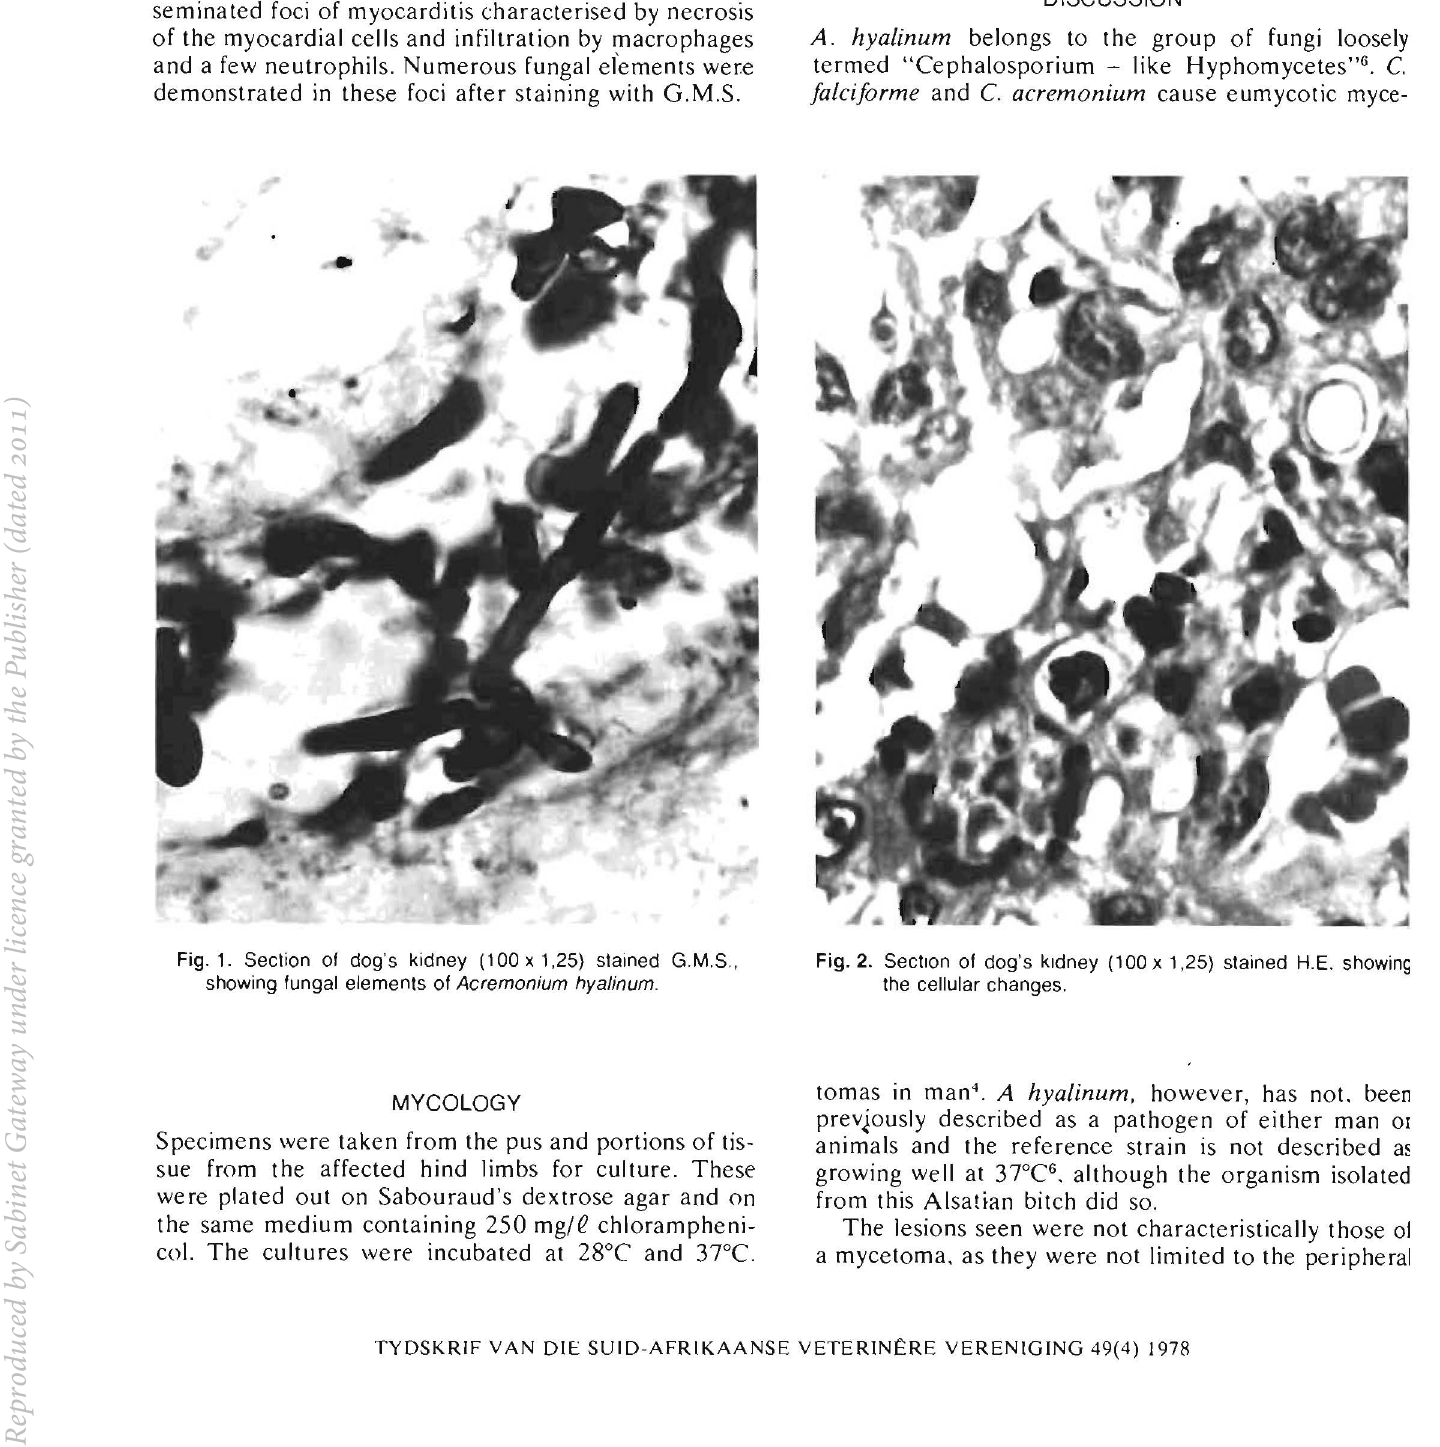
Fig. 2. Section of dog's kidney (100 x 1,25) stained H.E. showin~ the cellular